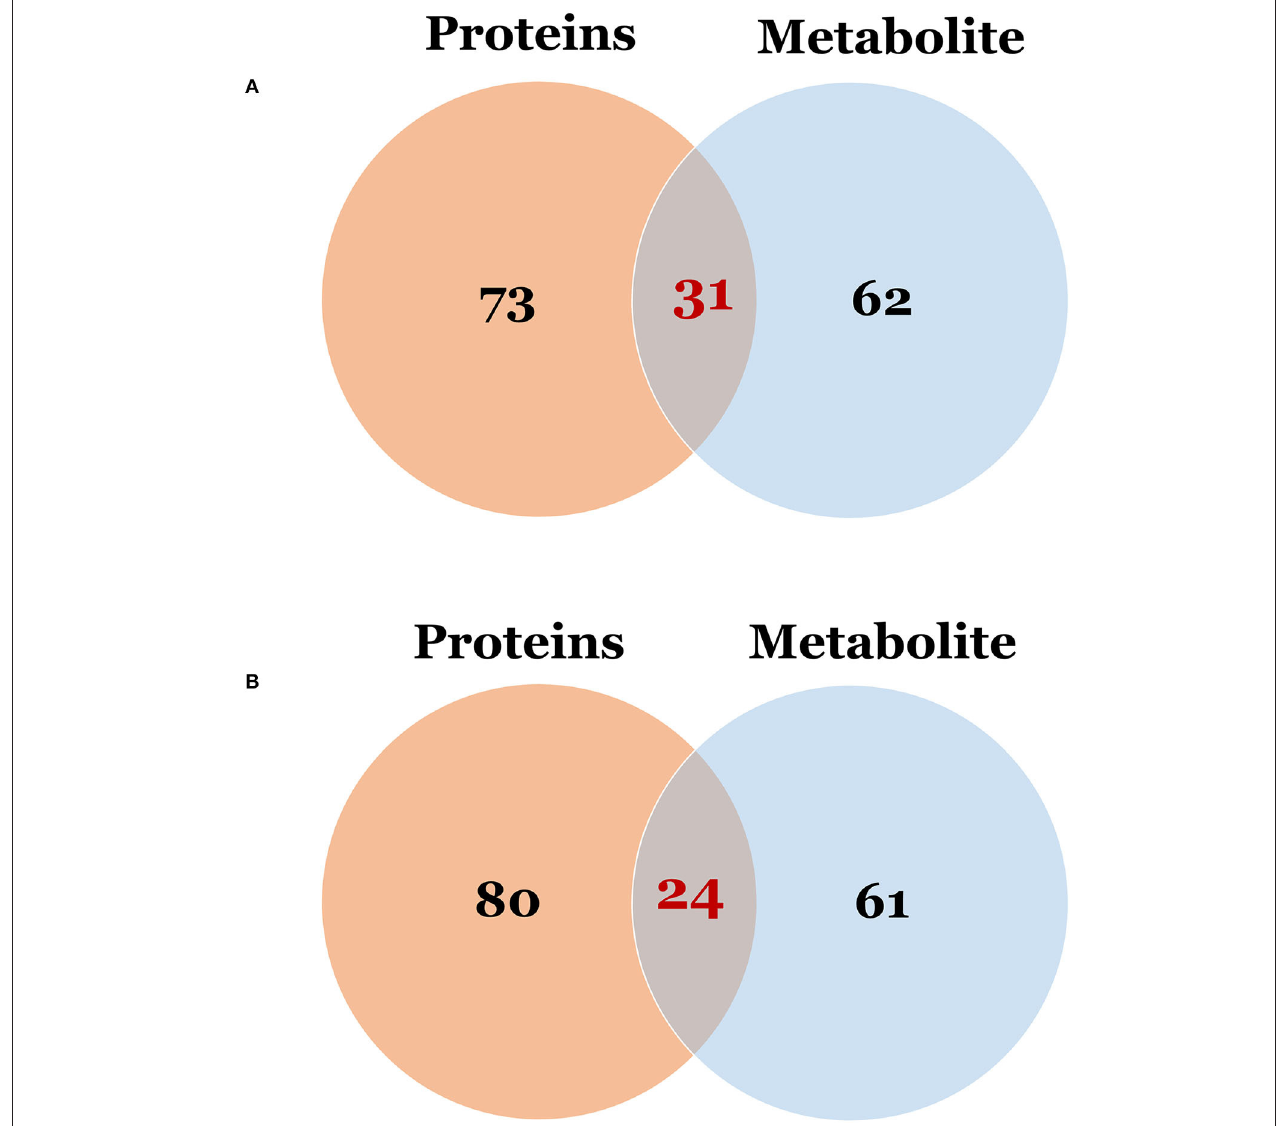
FIGURE 6 | The Venn diagram of the pathway in which differentially expressed proteins and metabolites were involved. (A) Differentially expressed proteins vs. metabolites in positive ion mode; (B) Differentially expressed proteins vs. metabolites in negative ion mode.